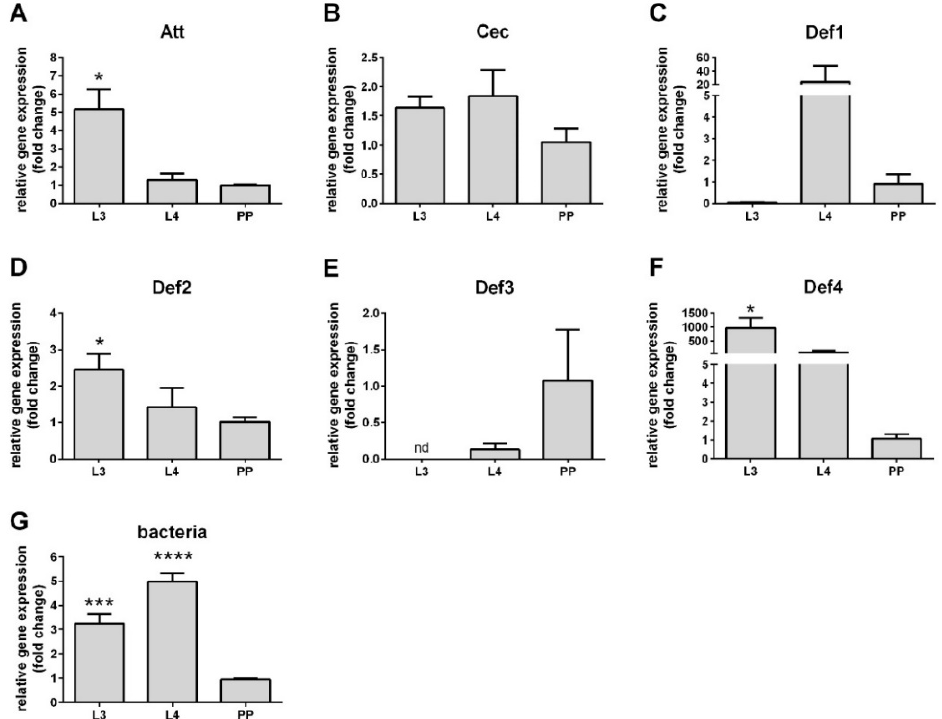
Figure 1. Relative gene expression of antimicrobial peptides (AMPs) in larval stages. ( A ) attacin; ( B ) cecropin, ( C ) defensin 1; ( D ) defensin 2; ( E ) defensin 3; ( F ) defensin 4; ( G ) bacteria 16S. The y -axis represents relative expression values expressed in foldchange in comparison to the pre-pupae stage. The x -axis represents larval stages L3, L4, and pre-pupal (PP). Vertical bars represent the average values of three independent experiments, and error bars represent the standard error. Asterisks indicate significant differences (* p < 0.05; *** p < 0.001; **** p < 0.0001). (nd) not